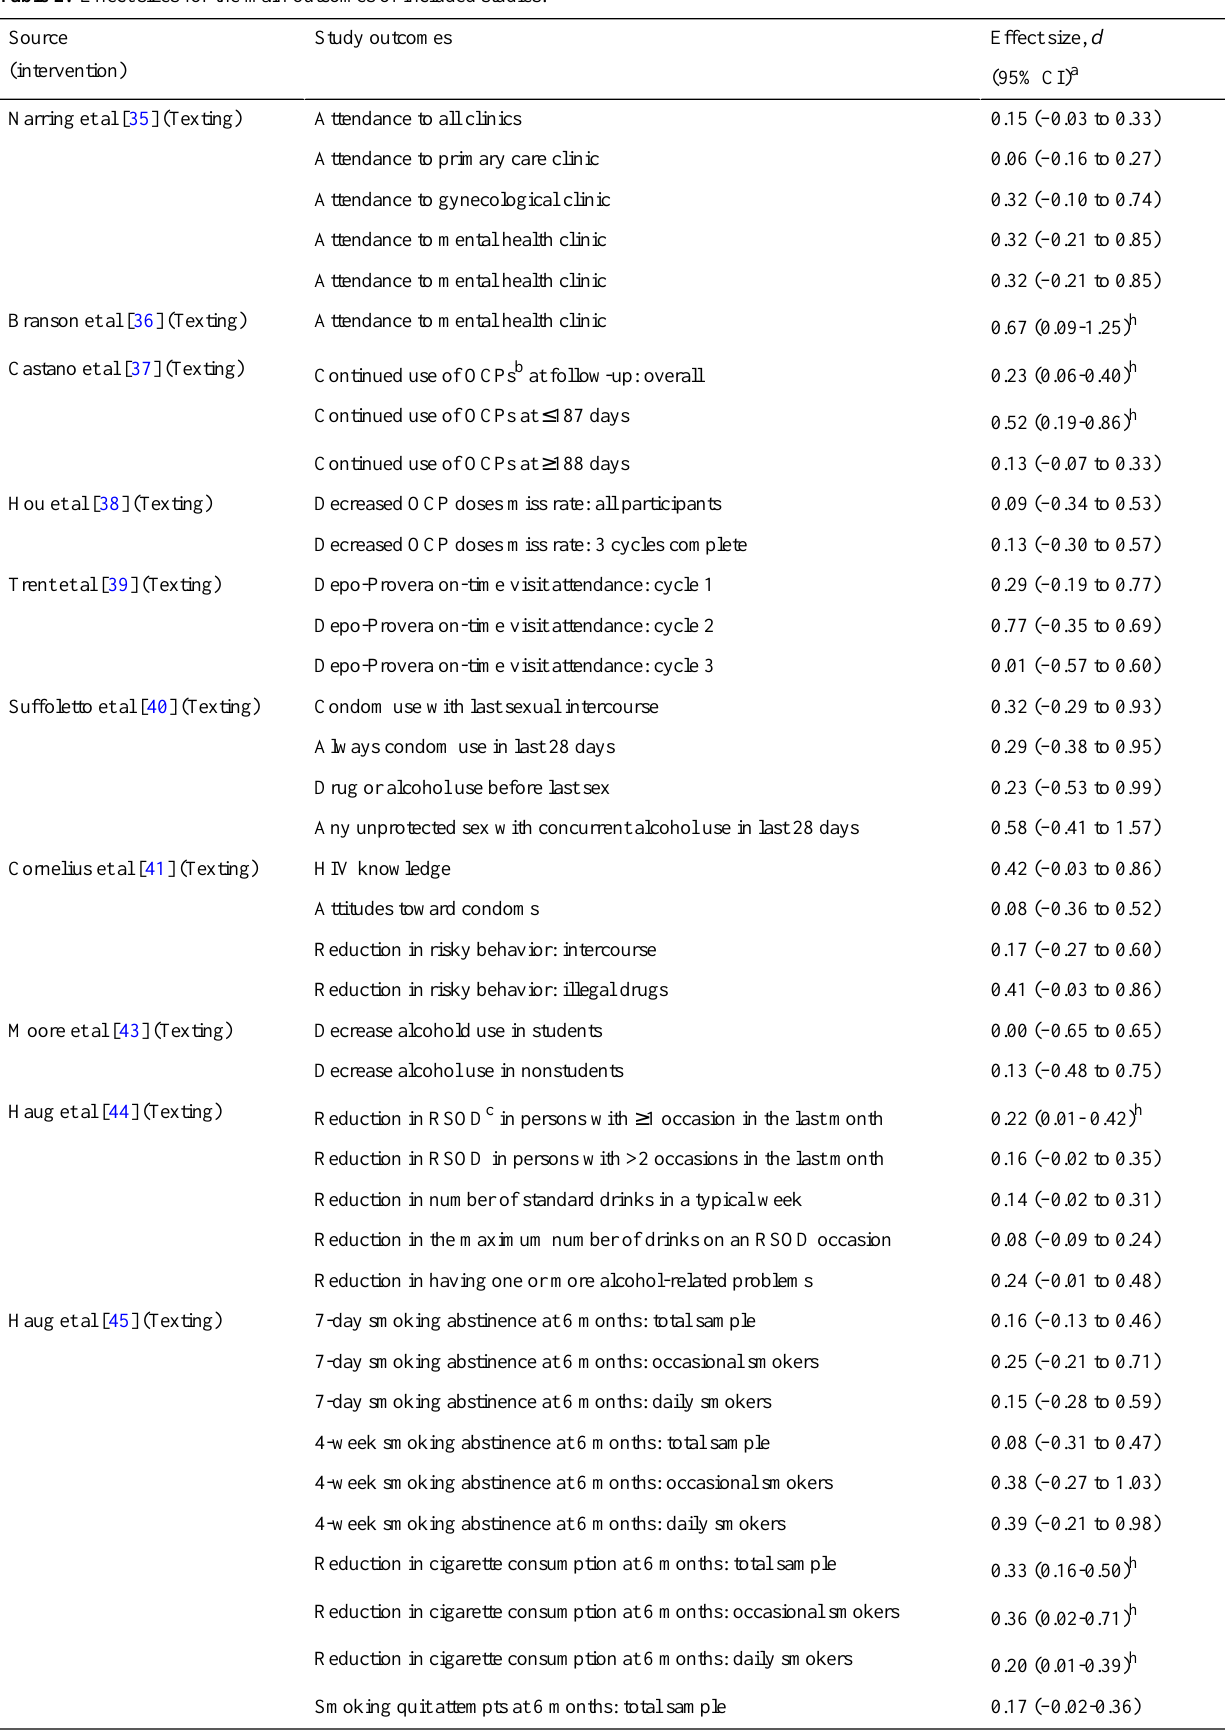
Table 2. Effect sizes for the main outcomes of included